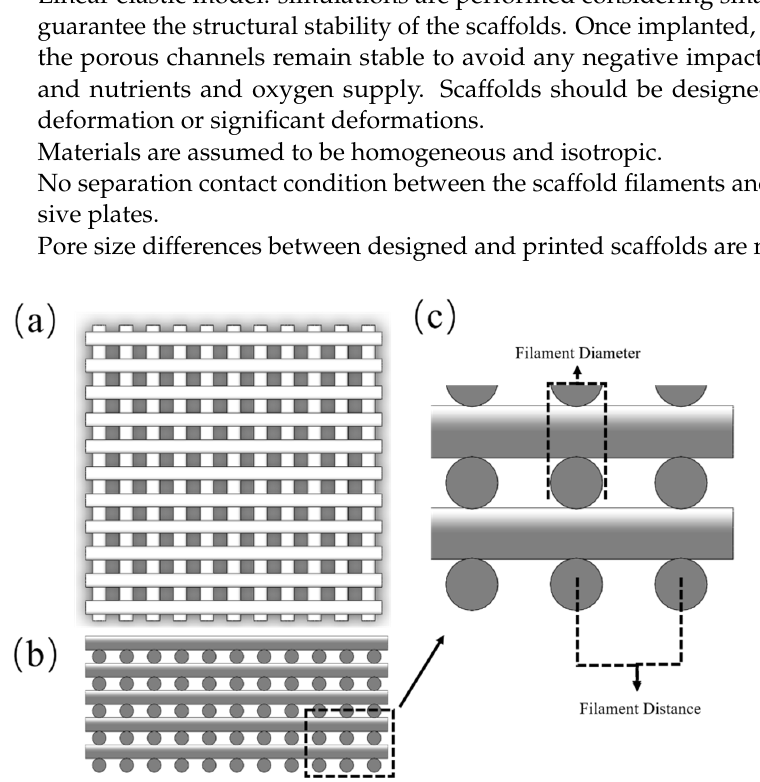
Figure 2. Scaffold configuration: ( a ) top view and ( b ) front view of the scaffold model. ( c ) Indication of filament distance and filament diameter.